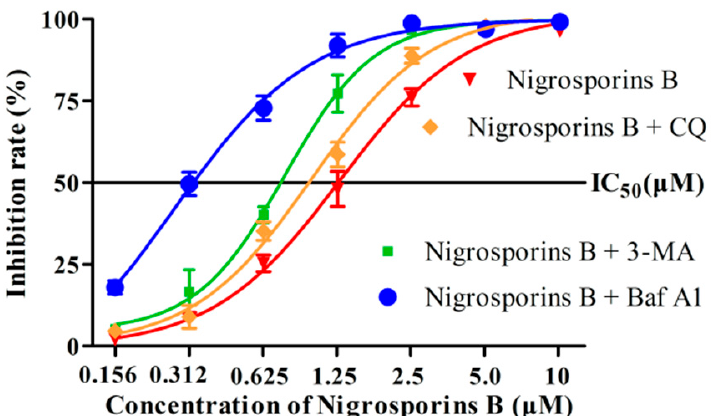
Figure 10. Nigrosporins B combined with or without 3-MA, CQ and Baf A1 inhibited the proliferation of Ca Ski cells, cells were treated with 3-MA, CQ and Baf A1 for 6 h, then treated with Nigrosporins B with different concentrations (10, 5, 2.5, 1.25, 0.625, 0.312, 0.156 µ M) for 48 h, and cell viability was measured by MTT assay.